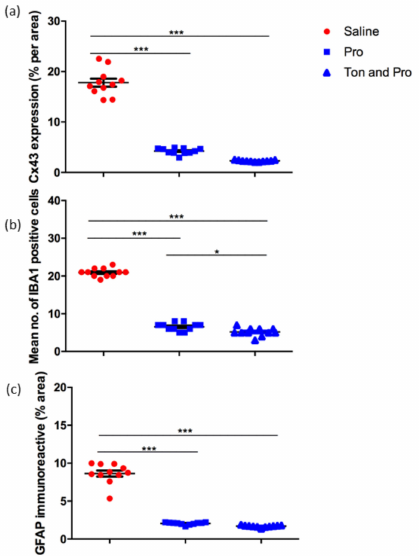
Figure 5. Quantification of Cx43 expression ( a ), mean number of Iba-1 positive cells/unit area ( b ) and GFAP immunoreactivity ( c ) in the saline, probenecid alone, tonabersat and probenecid combination treatment groups. Analysis revealed a significant decrease in Cx43, Iba-1 and GFAP in the treatment groups ( a – c ). The tonabersat and probenecid combination group further showed significantly fewer microglia compared to the probenecid group ( b ). Statistical analysis was conducted using one-way ANOVA, followed by Tukey’s multiple comparisons test. Significant values in comparison with results from the saline group are indicated with asterisks: * p < 0.05; *** p